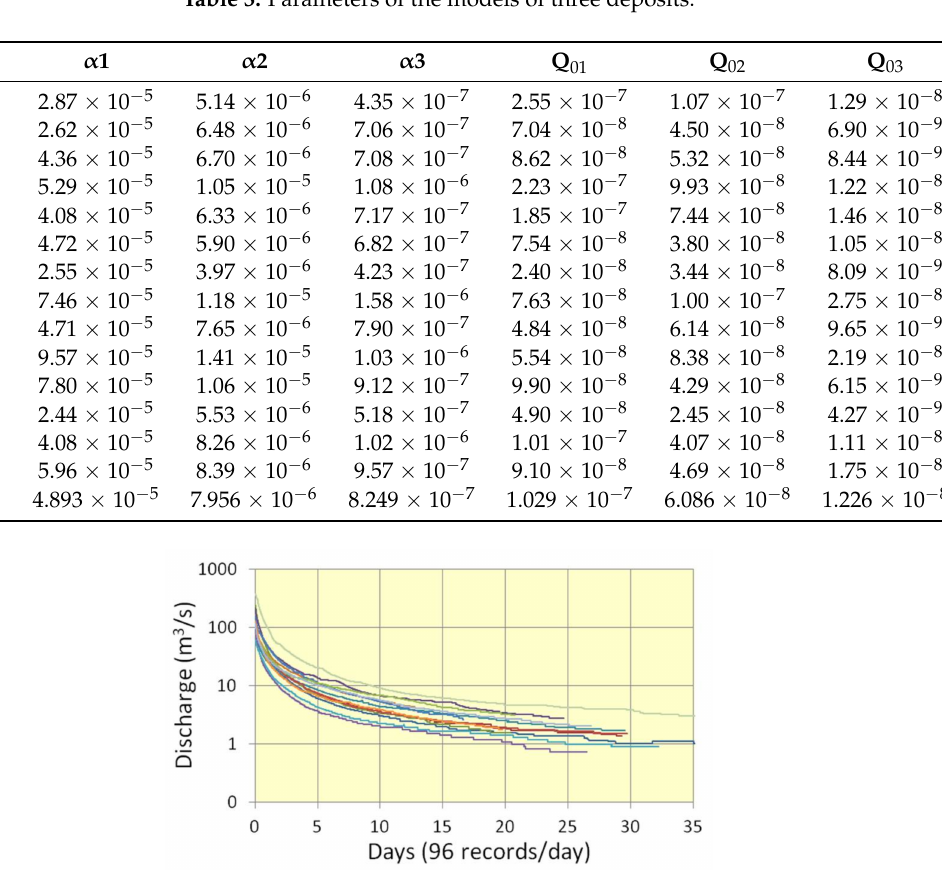
Table 3. Parameters of the models of three deposits.